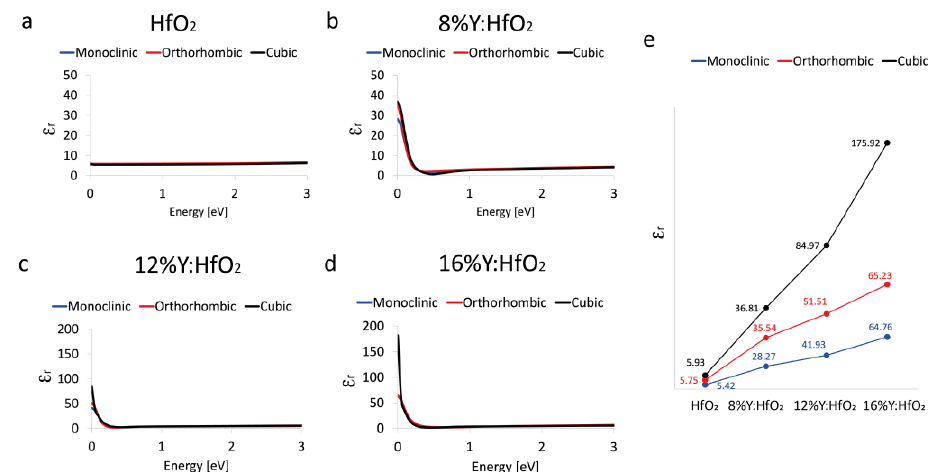
Figure 3. Real part of the dielectric constant. ε r of monoclinic P2 1 /c (blue curve), orthorhombic Pca2 1 (red curve), and cubic Fm 3̅ m (black curve) polymorphs evaluated between 0 and 3 eV of HfO 2 ( a ), 8% Y:HfO 2 ( b ), 12% Y:HfO 2 ( c ), and 16% Y:HfO 2 ( d ). The schematic trend of ε r at 0 eV as a function of the crystalline phase and Y content ( e ).